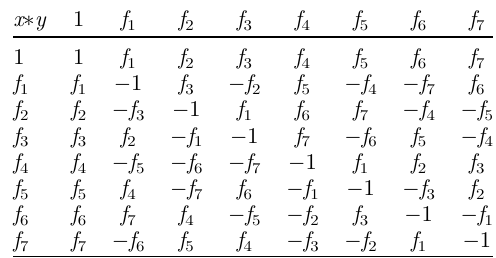
Table 2. Table of multiplication of